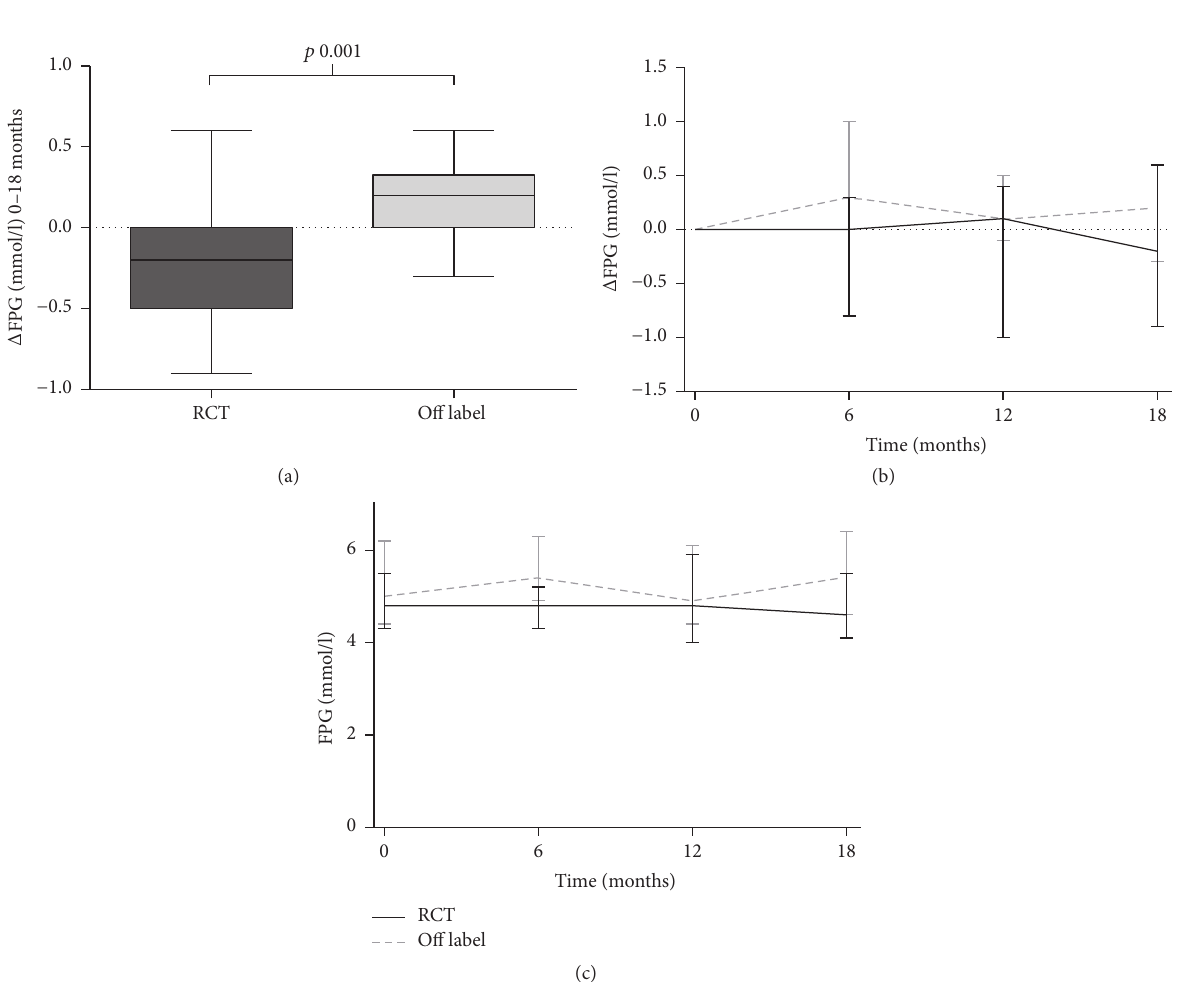
Figure 3: Change in fasted plasma glucose. (a) Change between baseline and 𝑡 = 18 months. (b) Median Δ FPG over time. (c) Median FPG over time. Graphs (b) and (c) represent median